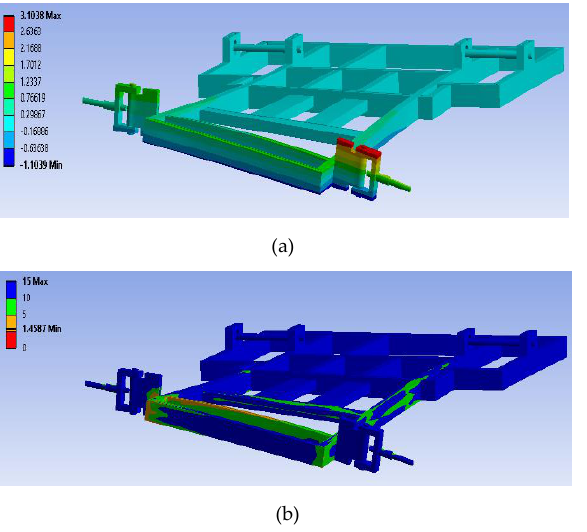
Figure 16: Deformation (a) and safety factor (b) factor of the fifth variation of chassis simulation